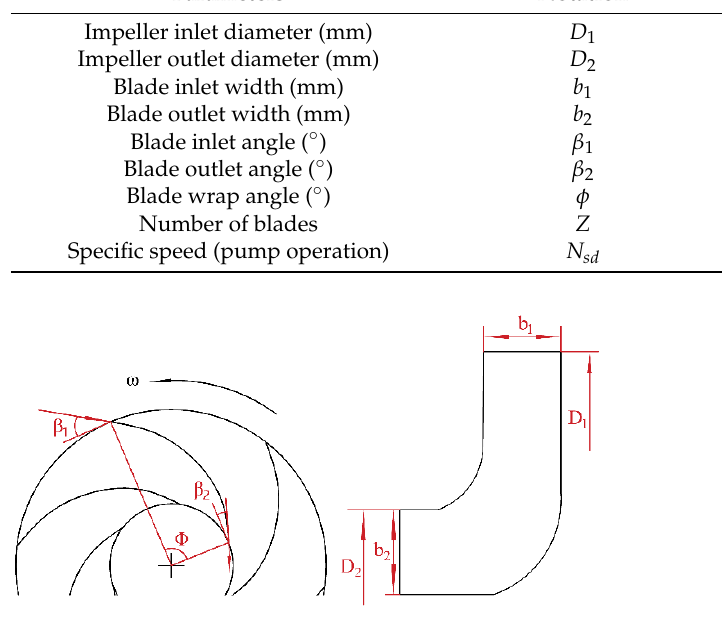
Figure 7. PAT runner diagram. Table 2. PAT operating parameters at the best efficiency point Table 1. Geometric parameters and performance parameter of the PAT.